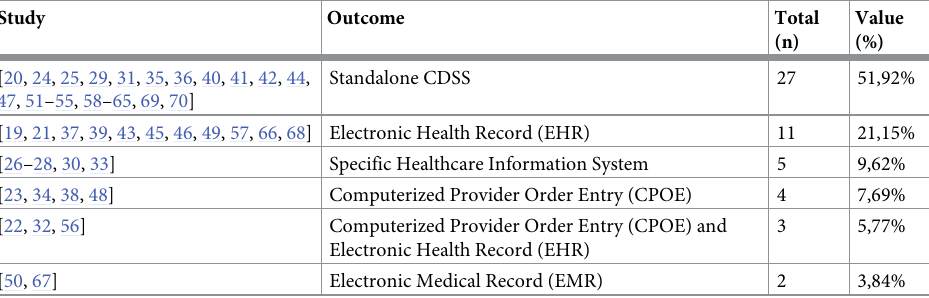
Table 5. Outcomes of system